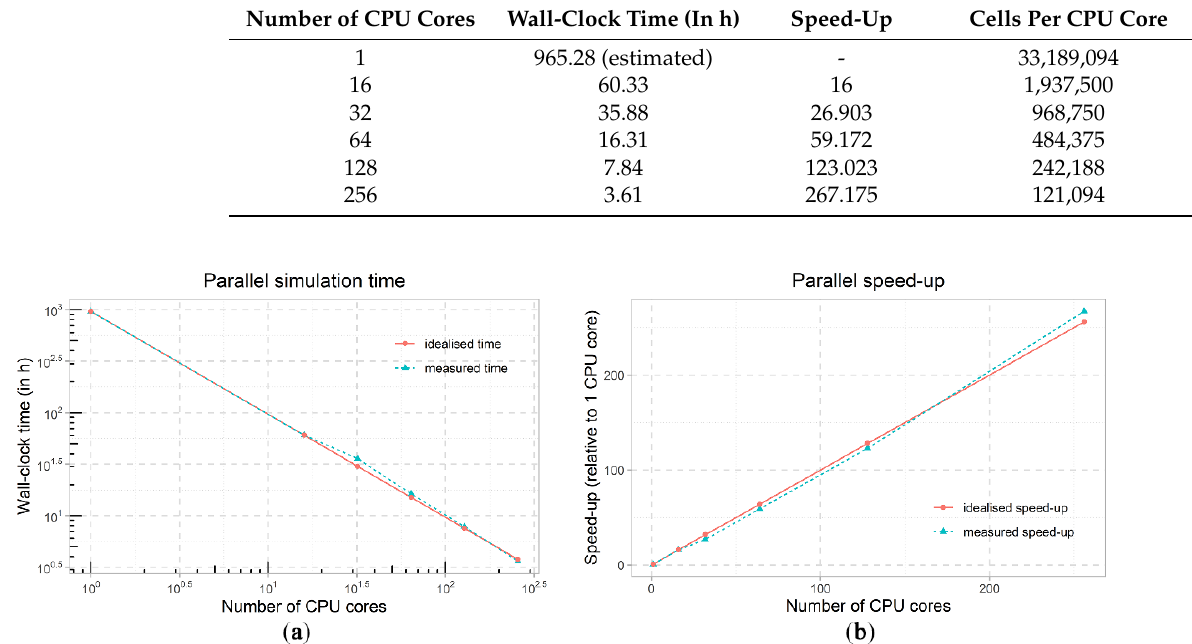
Figure 9. Parallel simulation time and speed-up: ( a ) Parallel simulation time; ( b ) Parallel simulation speed-up.